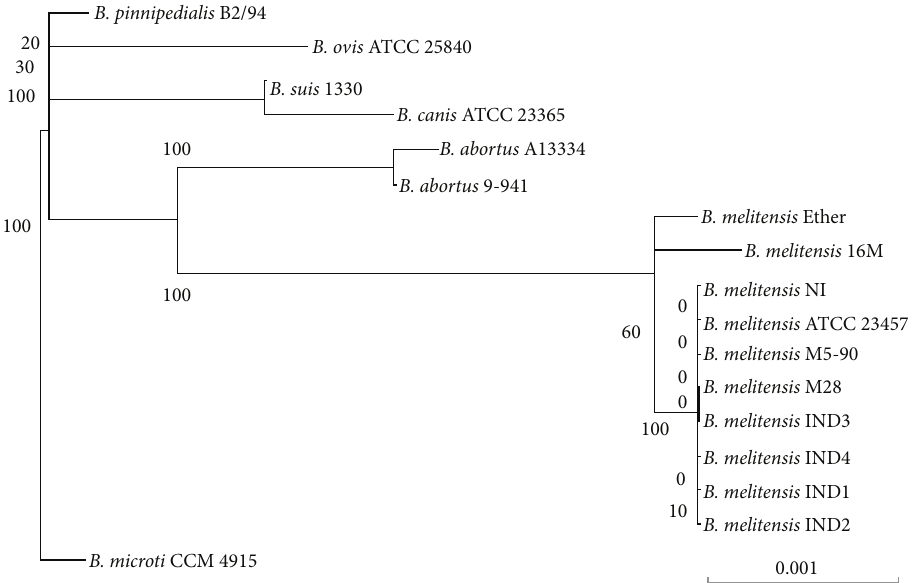
Figure 1: Phylogenetic tree based on MLST analysis. Seven housekeeping genes and two loci from outer membrane protein 25 and an intergenic region, respectively, were used for MLST analysis. Bootstrap percentages retrieved in 100 replications are shown at the nodes.